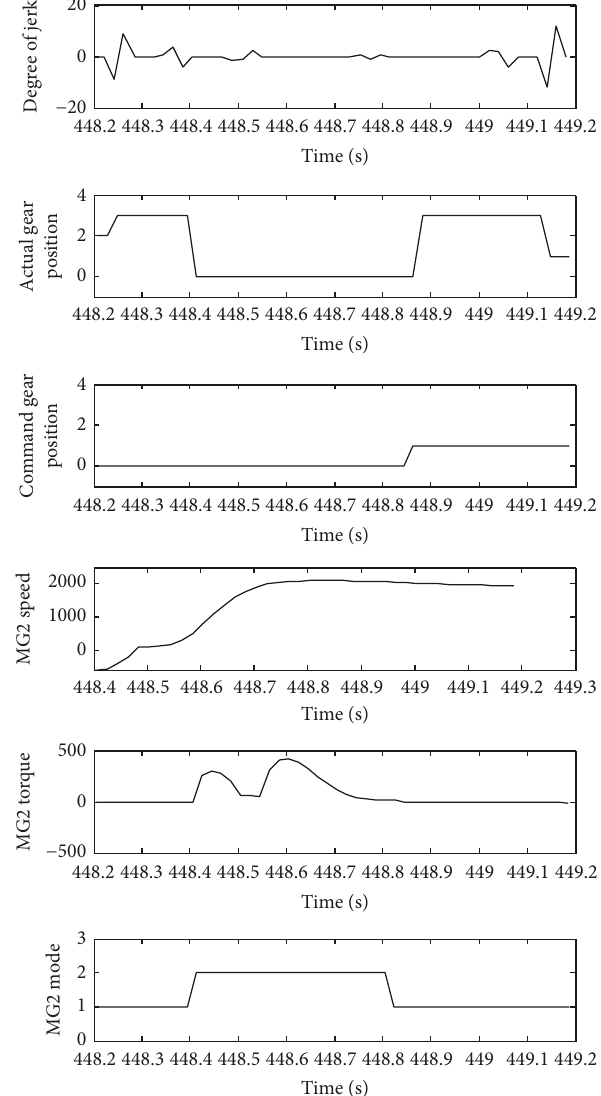
Figure 23: The parameters curves during downshift process.